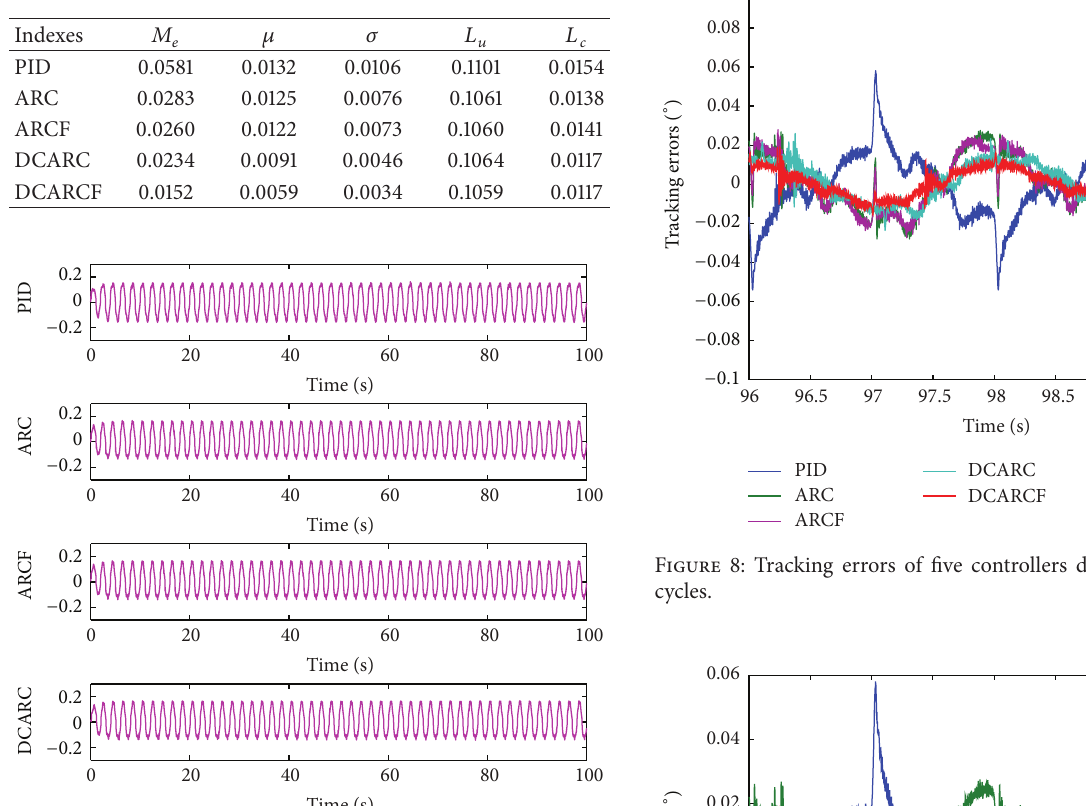
Table 1: Performance indexes during the last two seconds.